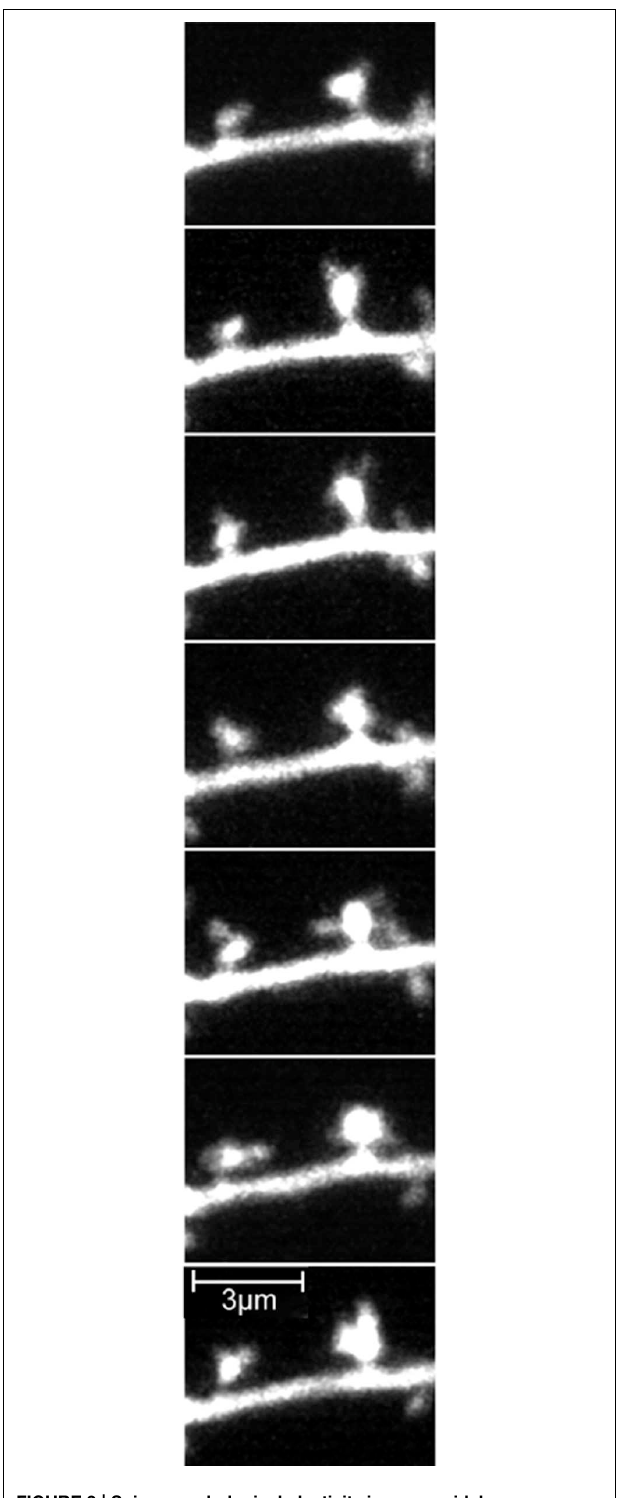
FIGURE 3 | Spine morphological plasticity in a pyramidal neuron. Frames from a two-photon movie of 8.5min duration of GFP labeled pyramidal neurons of postnatal cortical brain slice from a postnatal mouse. Note the large morphological plasticity of the spines. Reprinted with permission from (Portera-Cailliau et al.,